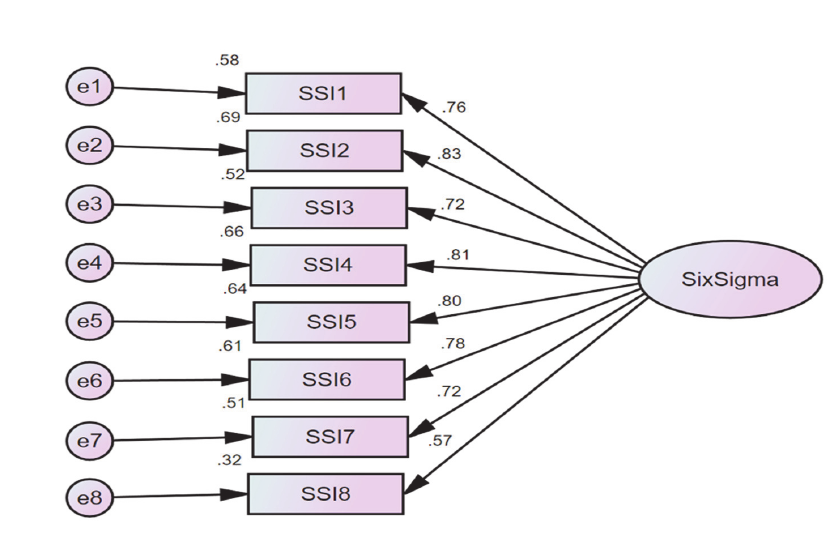
Fig. 1. Confirmatory Factor Analysis of Perceptions About Six